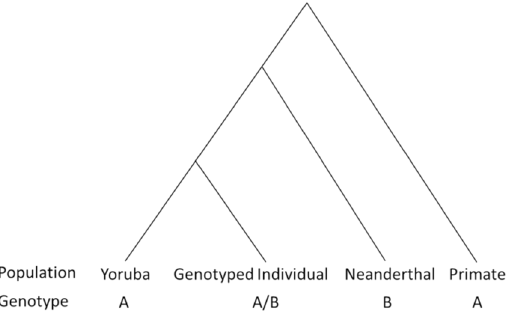
Figure 6. Derivation of NeanderScore. Phylogenic tree showing relationship of Yoruba, a genotyped individual, Neanderthal and Primates. At a given SNP, Yoruba and Primates contain the ancestral allele ( A ), Neanderthal contains the derived allele ( B ) and the genotyped individual may have either allele ( A , B ).